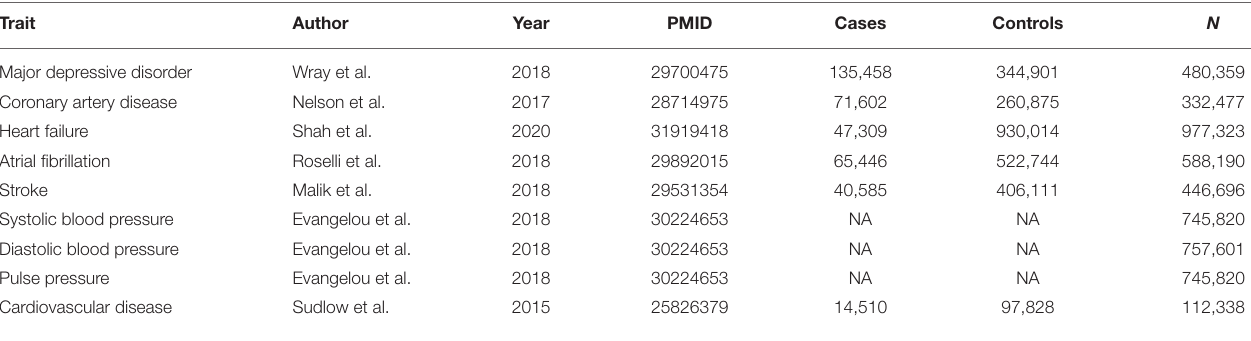
TABLE 1 | Summary information of the